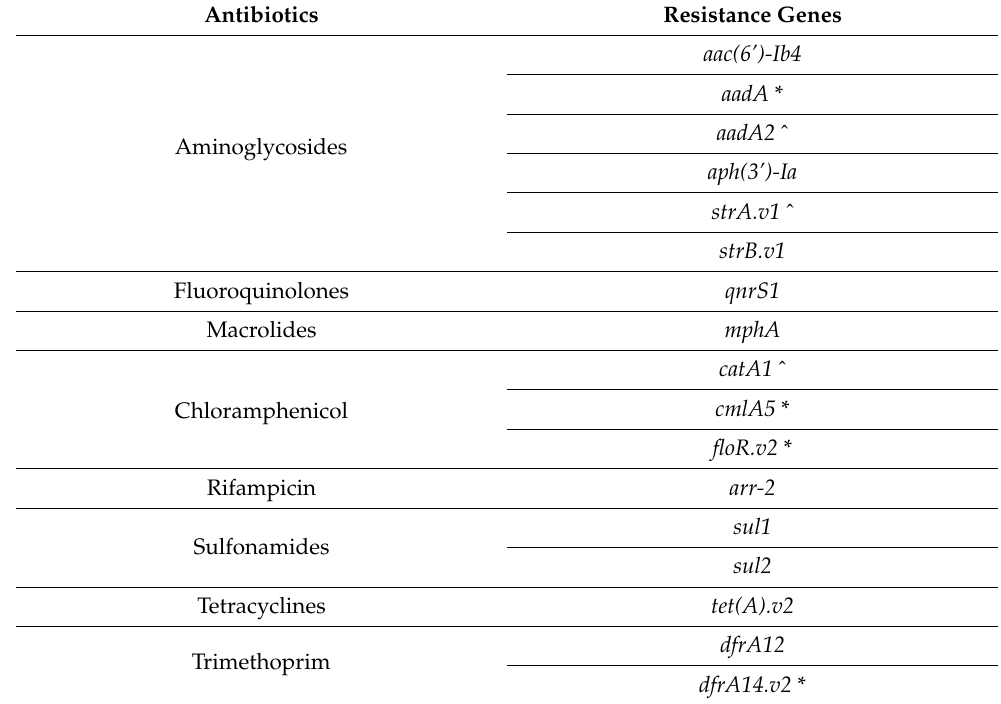
Table 2. Antimicrobial resistance genes found by Whole Genome Sequencing.